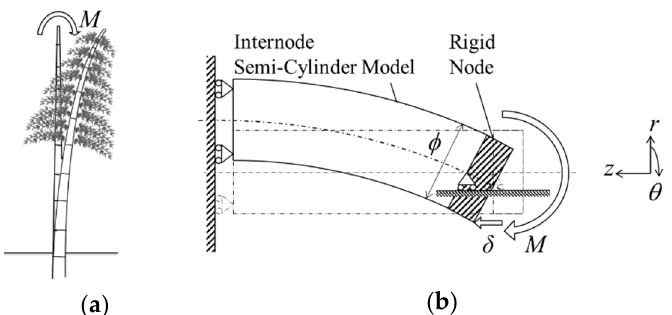
Figure 5. ( a ) Bending deformation due to external loading in natural bamboo; ( b ) boundary condition in bending mode setup.